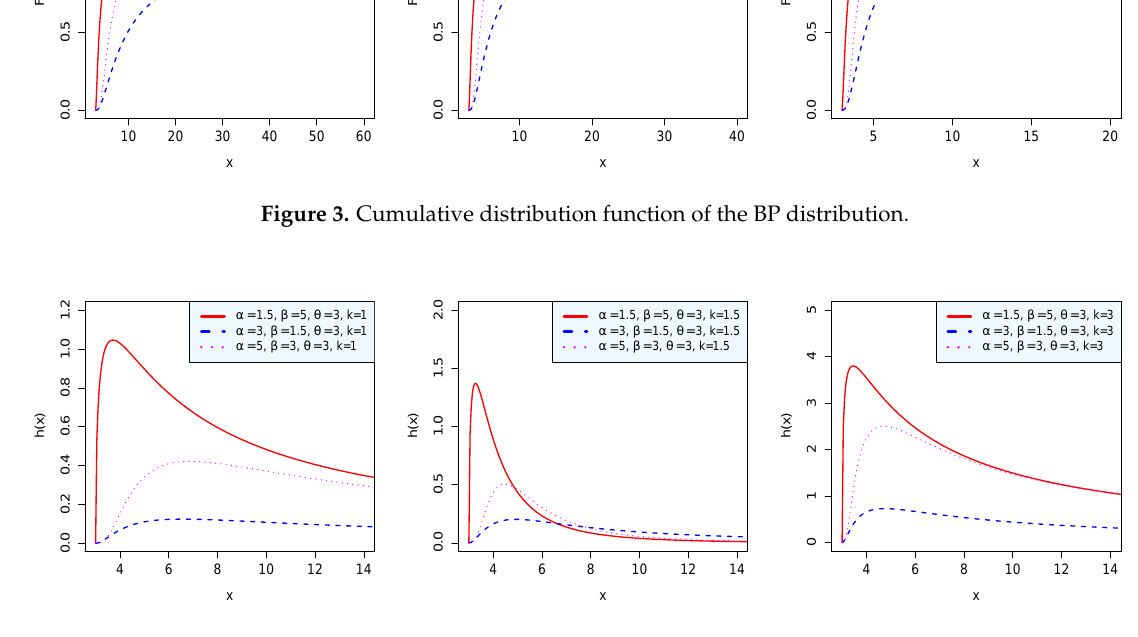
Figure 4. Hazard rate of the BP